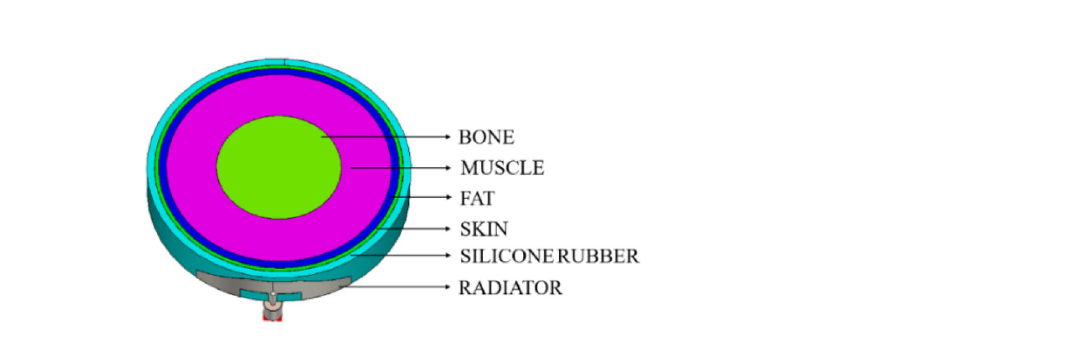
Figure 21. Cylindrical human body model for SAR